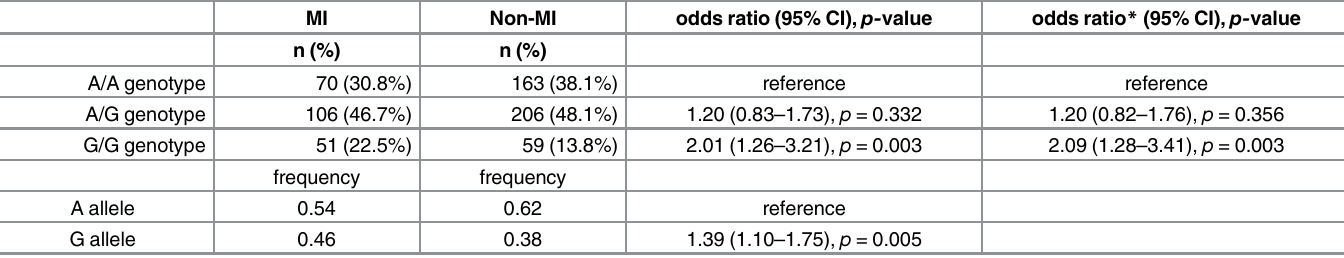
Table 1. Association between SNP rs4773144 and MI incidence/prevalence in CHD patients. MI Non-MI odds ratio (95% CI), p- value n (%) n